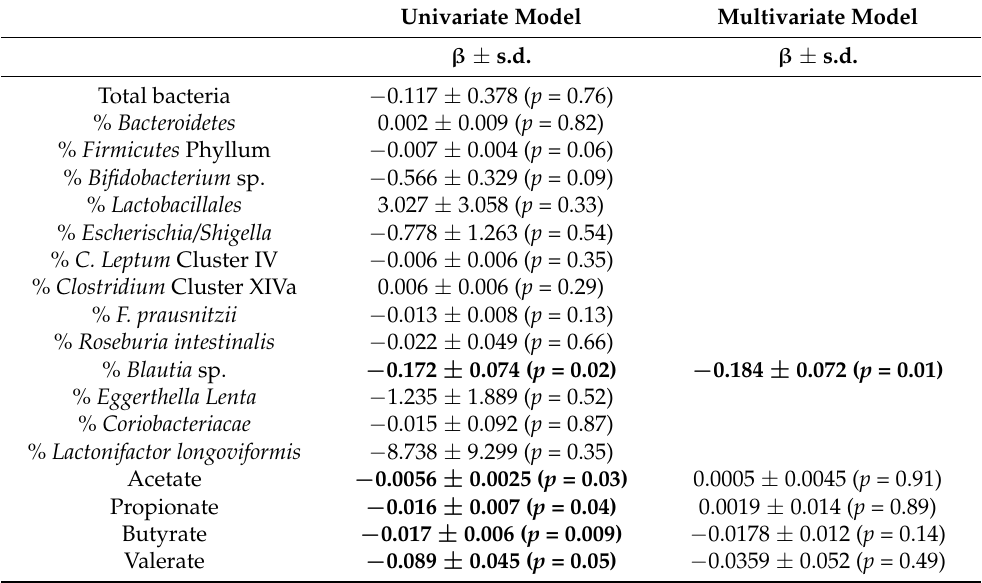
Table 6. Relationship between LXR gene expression in Caco-2 cells exposed to FW from the whole studied population and short chain fatty acids in FW or abundance of given bacterial genes in